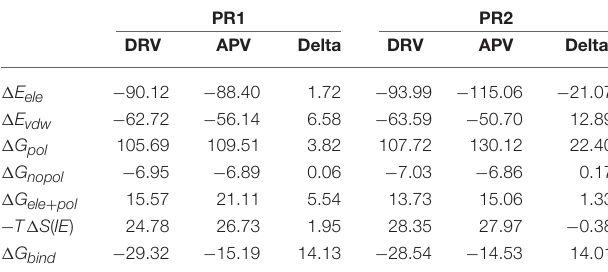
TABLE 3 | Binding free energy and delta of DRV and APV complexes under PPC force